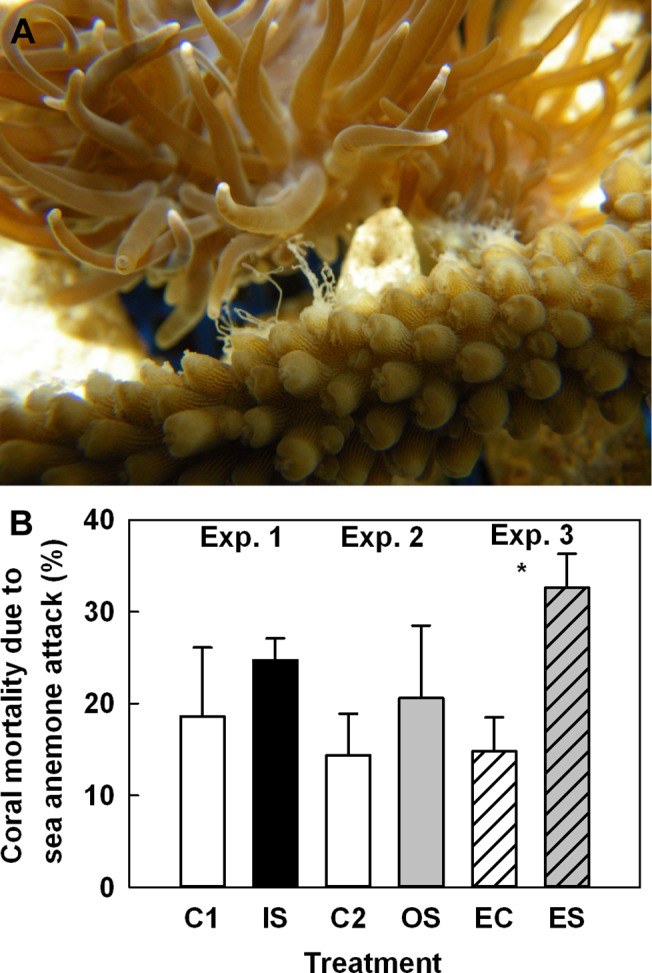
Sediment loading-induced inflation of modified attack tentacles of the sea anemone Mesactinia genesis.These attack tentacles (A) were capable of injuring or killing nearby corals. Coral mortality due to sea anemone attack (B). C = control mesocosms, IS = inorganic sediment-enriched mesocosms, OS = organic sediment-enriched mesocosms, ES = nutrient and sediment-enriched mesocosms, EC = nutrient-enriched mesocosms. Comparisons between control and experimental mesocosms were conducted with student’s t-tests (* p < 0.05).